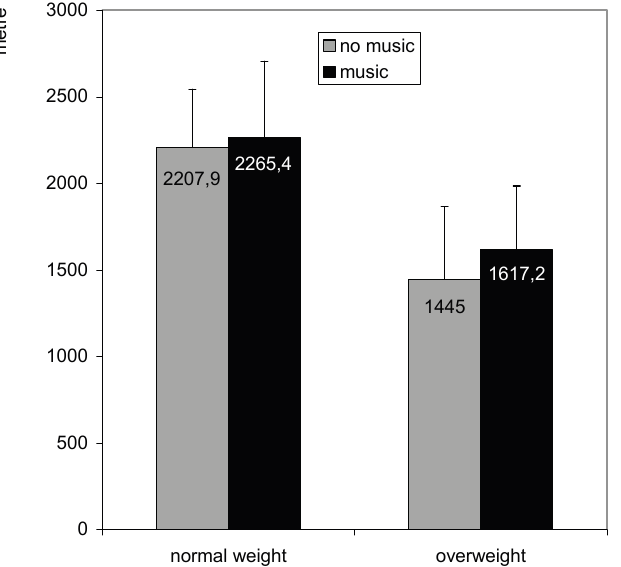
Figure 1. Running distance on the Cooper test with and without attentional distraction by music in normal-weight and overweight